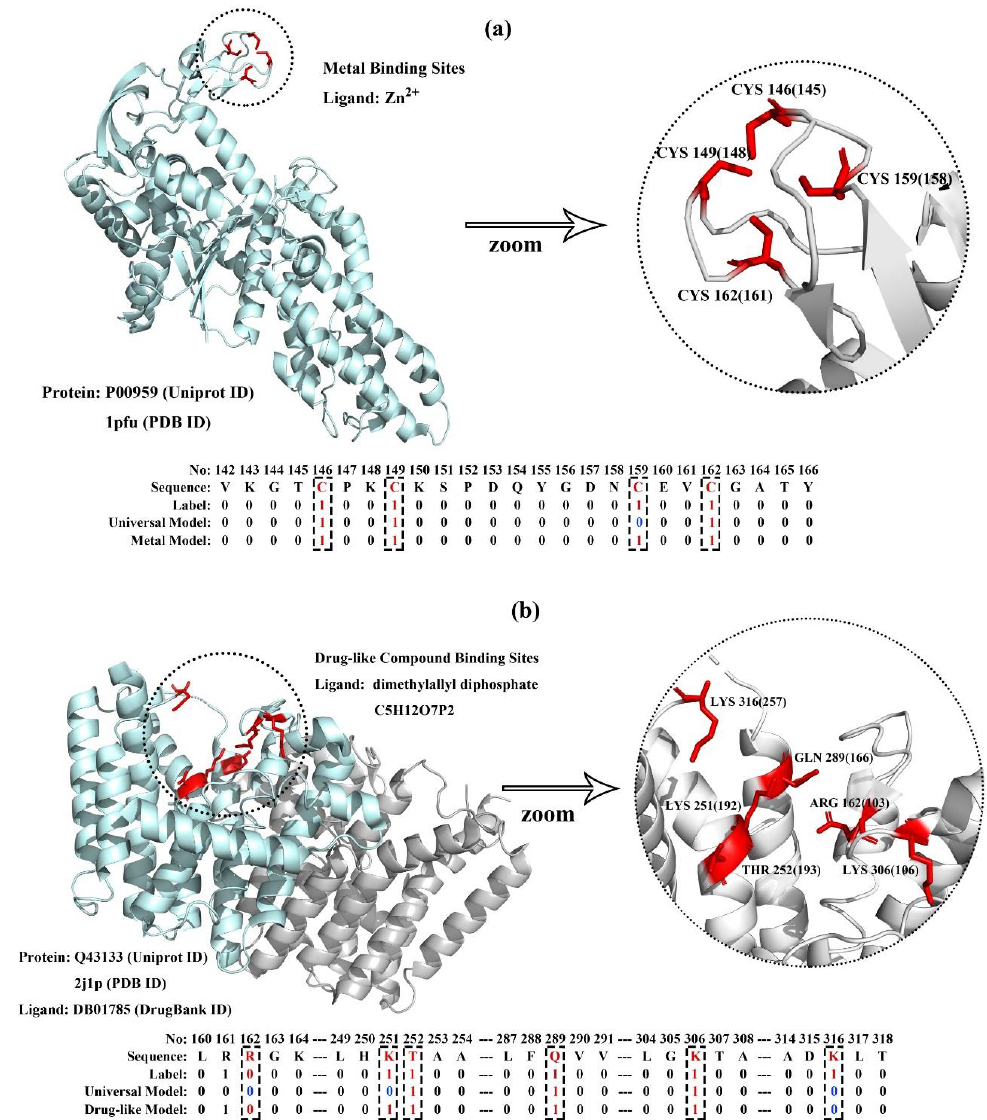
Figure 5. Visualization of membrane protein-ligand binding sites and their corresponding prediction result generated by MPLs-Pred with the universal model and ligand-specific models. As examples: ( a ) P00959: metal-binding MP with four zinc ion-binding residues, and ( b ) Q43133: drug-binding MP with six dimethylallyl diphosphate-binding residues.